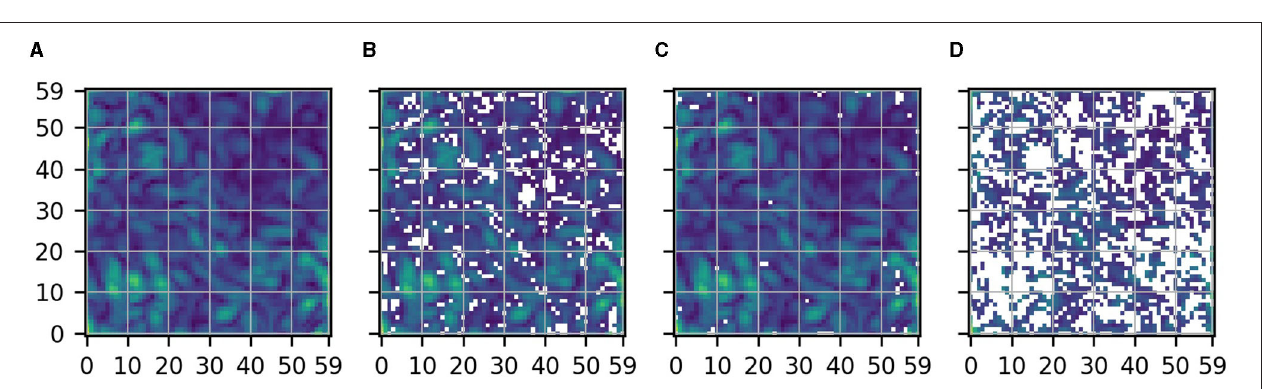
FIGURE 6 | Same as Figure 3 but for the logistic regression model. (A) Original. (B) Sampling. (C) Size. (D)